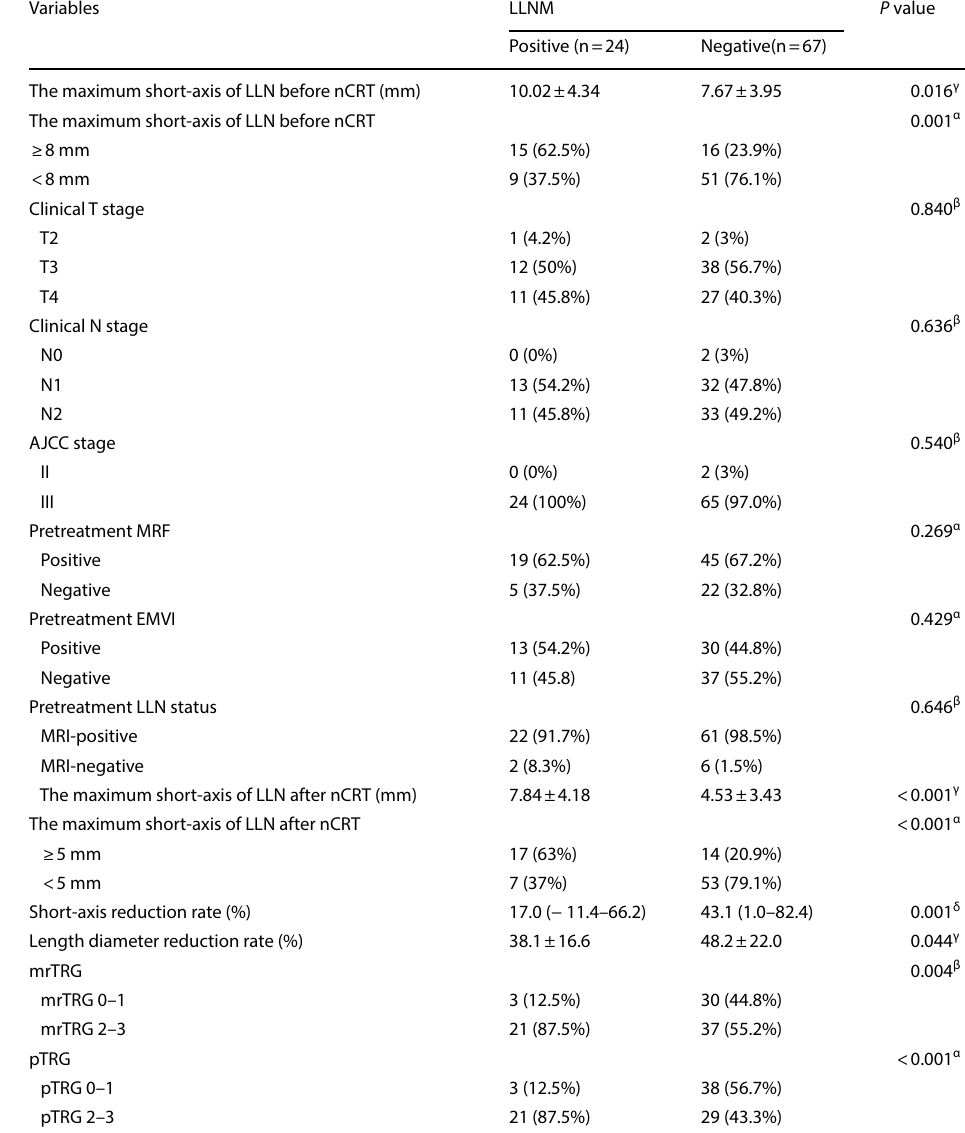
Table 2 The imaging data and pTRG of the study patients grouped by